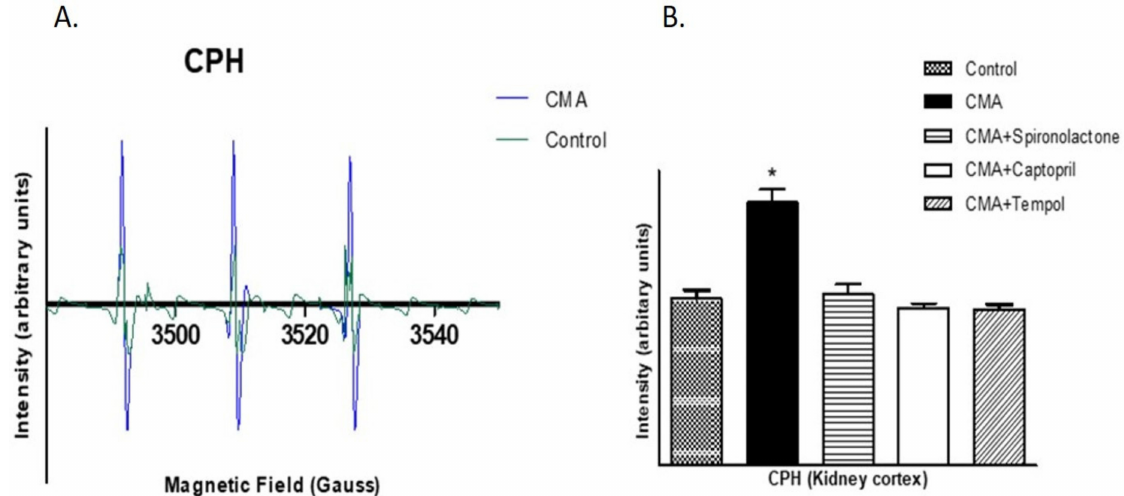
Figure 12. EPR analysis for peroxynitrite. ( A , B ) show the EPR intensities and the quantified EPR signal area of the first derivative signals, respectively, for